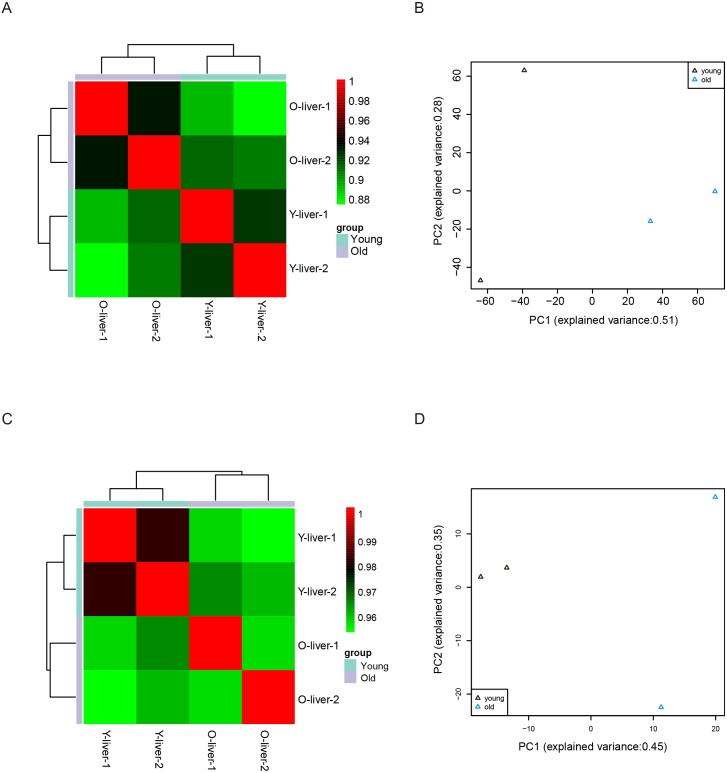
Variance between old and young individuals.(A) Pearson’s correlation coefficient heat map of mRNA and lncRNA between YL and OL. The identified mRNA and lncRNA expression values (TPM) in every sample were used to perform the Pearson’s correlation coefficient analysis, and values closer to 1 were less variable. (B) Principal Component Analysis (PCA) plot based on the normalized expression level (log2 (TPM)) of identified mRNAs and lncRNAs. (C) Pearson’s correlation coefficient heat map of miRNAs between YL and OL. The identified miRNA expression values (TPM) in every sample were used to perform the Pearson’s correlation coefficient analysis, and values closer to 1 were less variable. (D) PCA plot based on normalized expression level (log2 (TPM)) of identified miRNAs.